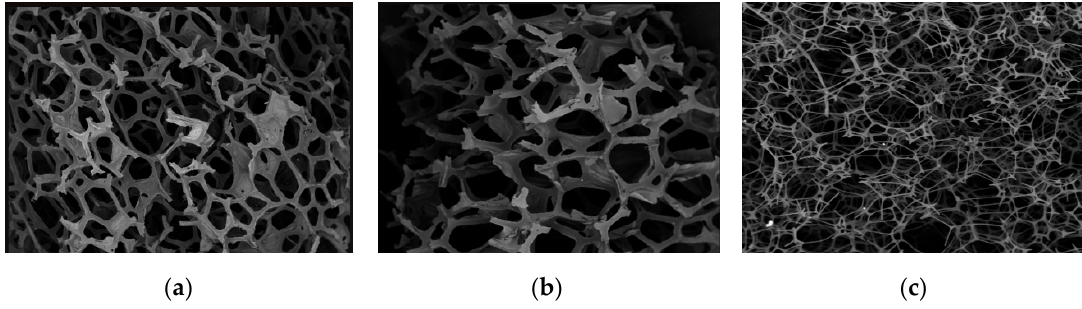
Figure 3. SEM images of ( a ) car sponge; ( b ) dishwasher sponge; ( c ) audio sponge [3].